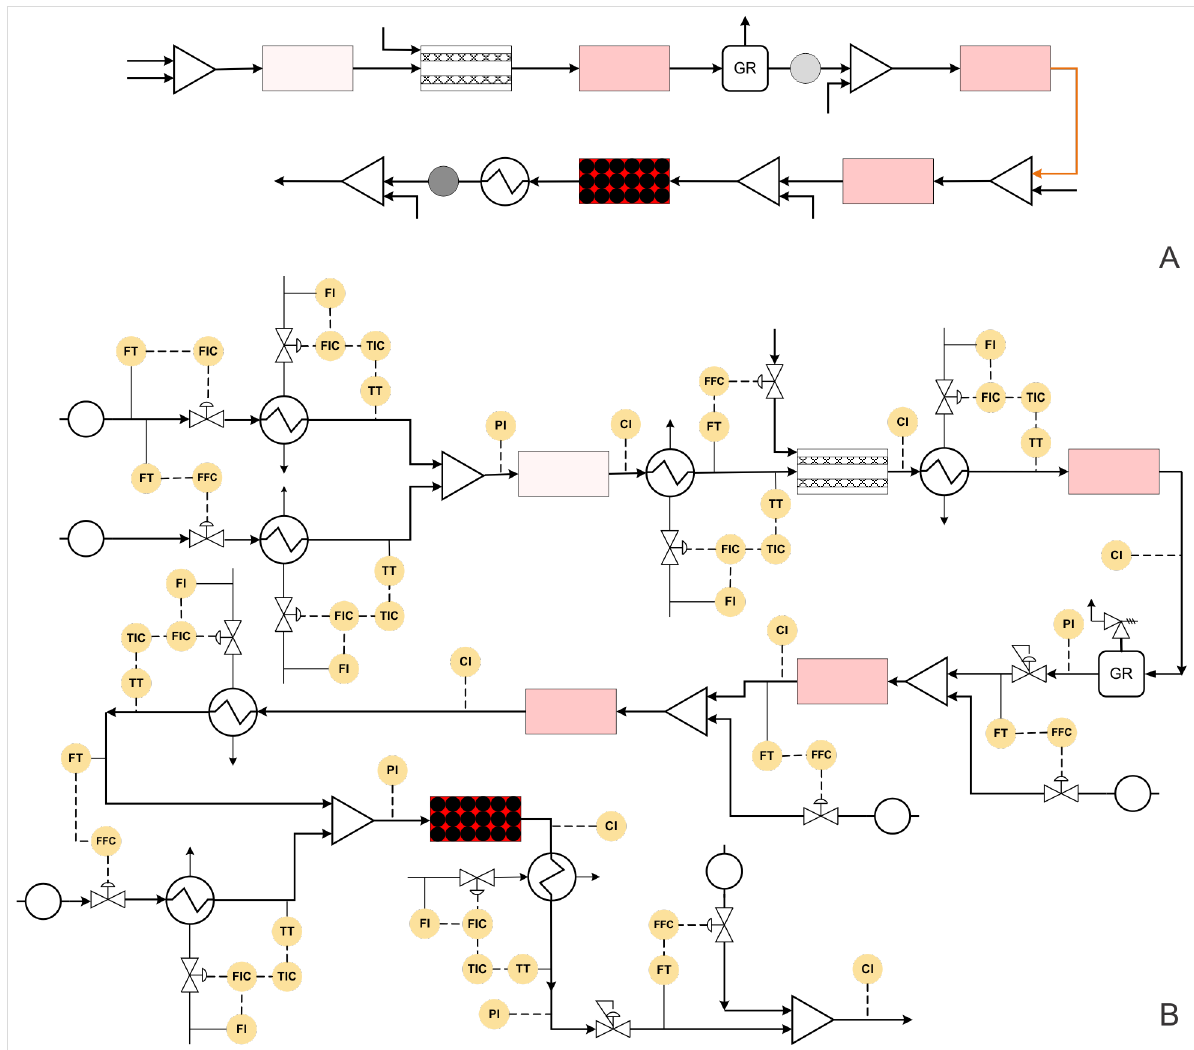
Figure 10: (A) Block diagram representation of the process shown in Scheme 8, (B) piping and instrumentation diagram of Scheme 8.